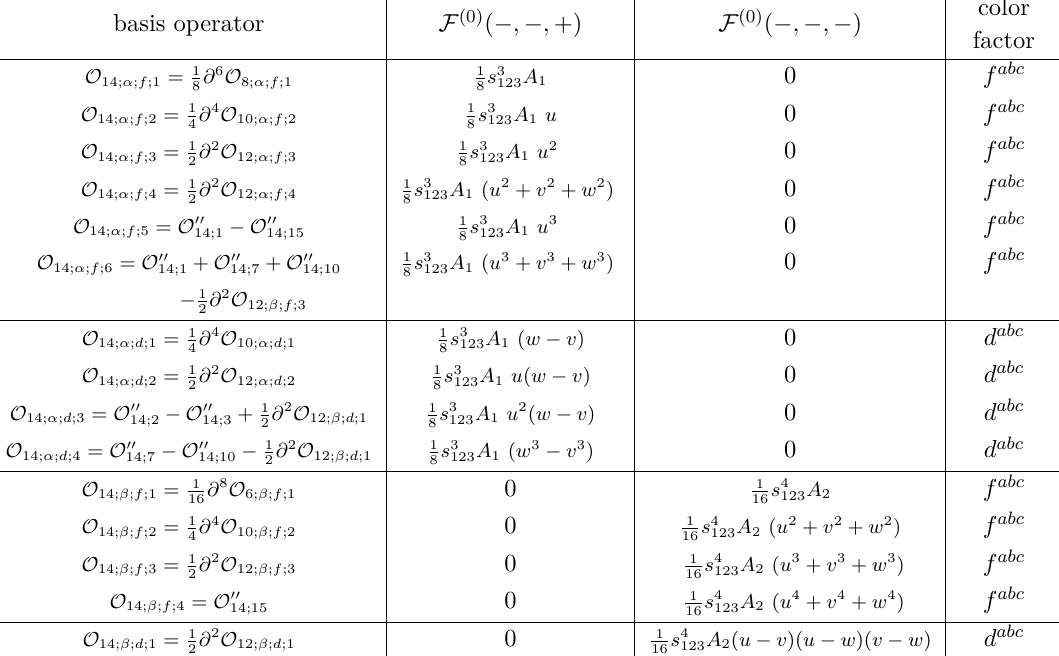
Table 15 . Final basis operators at dimension